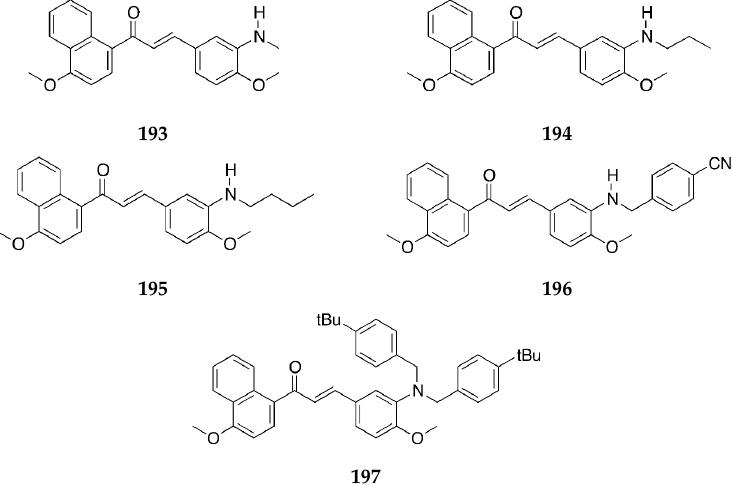
Figure 64. Chemical structure of N -alkyl 3′-aminochalcone derivatives. Table 28. Antiproliferative activity of 193 – 197 against human colon carcinoma cells HCT116 and human hepatocellular liver carcinoma cells